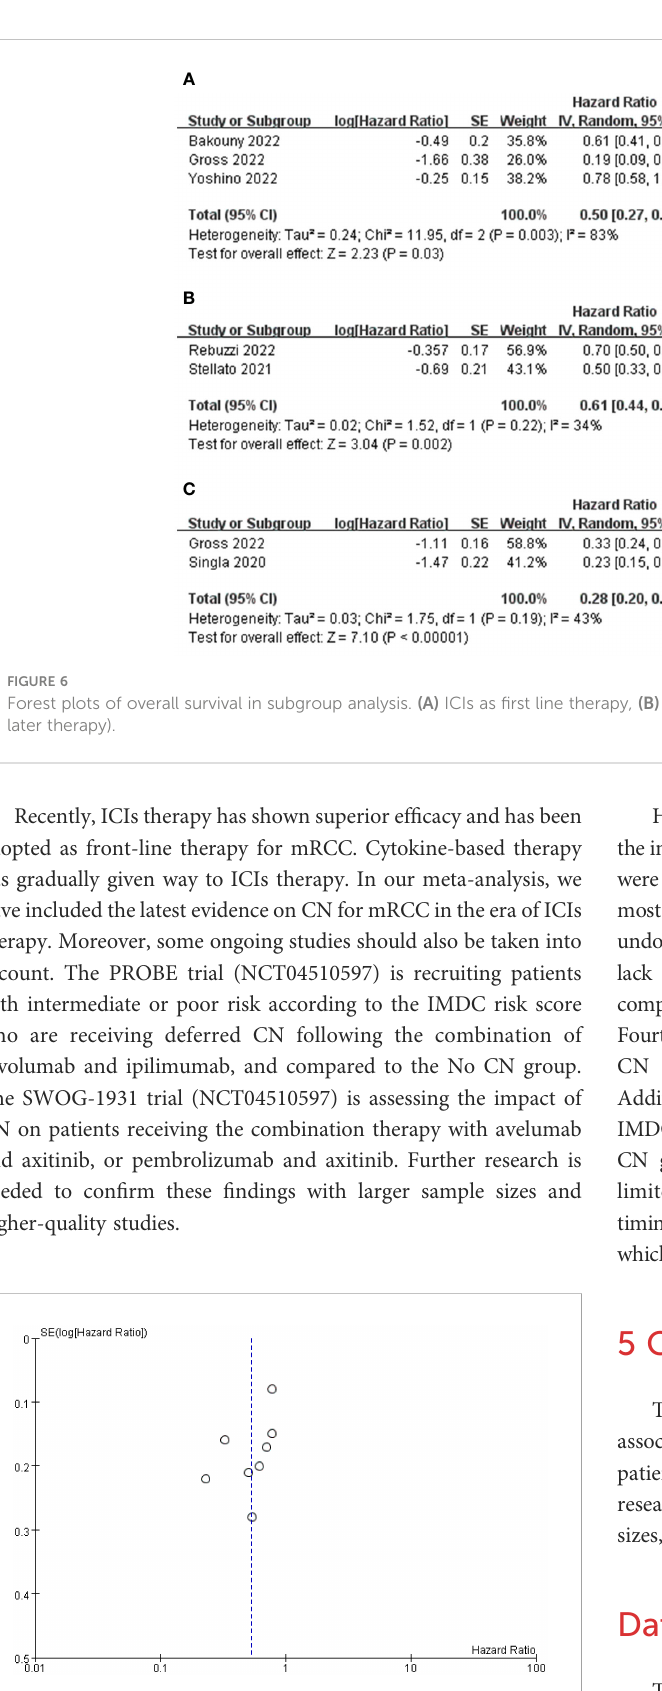
FIGURE 7 Funnel plot of the studies represented in the